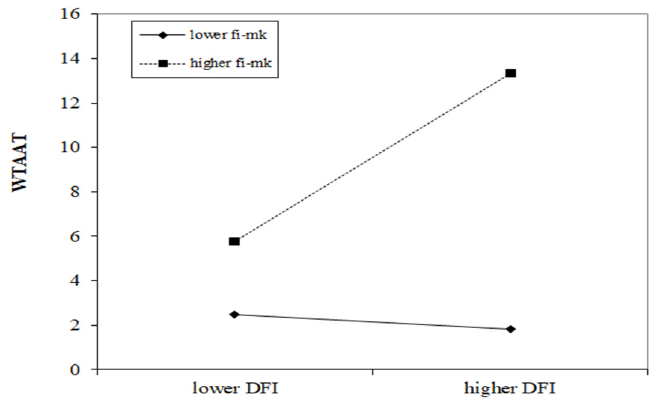
Figure 1. The moderating effect.